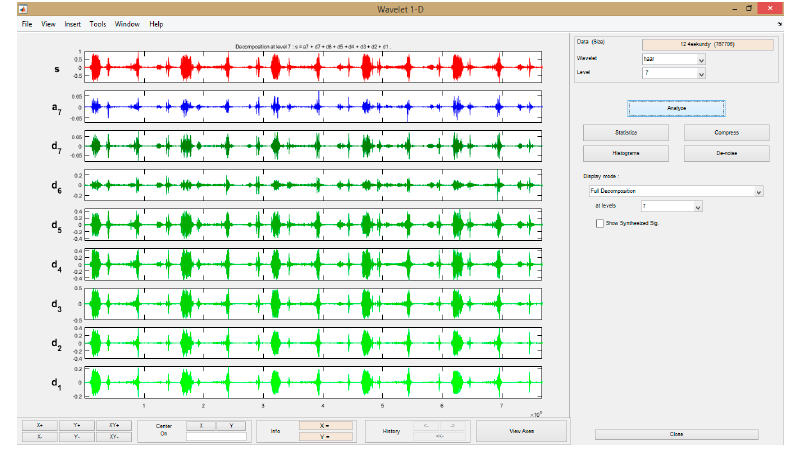
Figure 14. The wavelet decomposition using the Haar function of a correctly working valve unit.